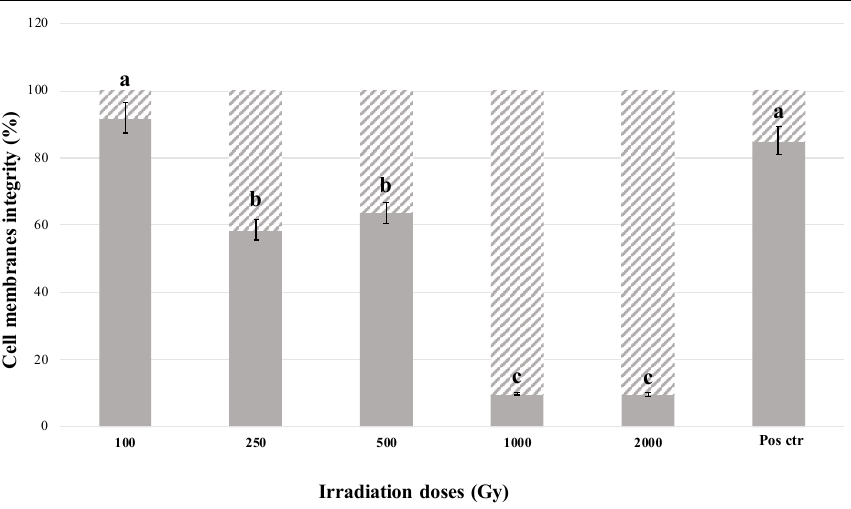
Figure 3. Percentage of intact (grey bars) and damaged cell-membranes (lined bars) measured with PMA assay coupled with qPCR of C. antarcticus exposed to accelerated Fe ions. Pos Ctr = DNA of C. antarcticus colony growth in physiological conditions. The same letters above bars indicate that the values are not statistically significant according to the t test ( p ≤